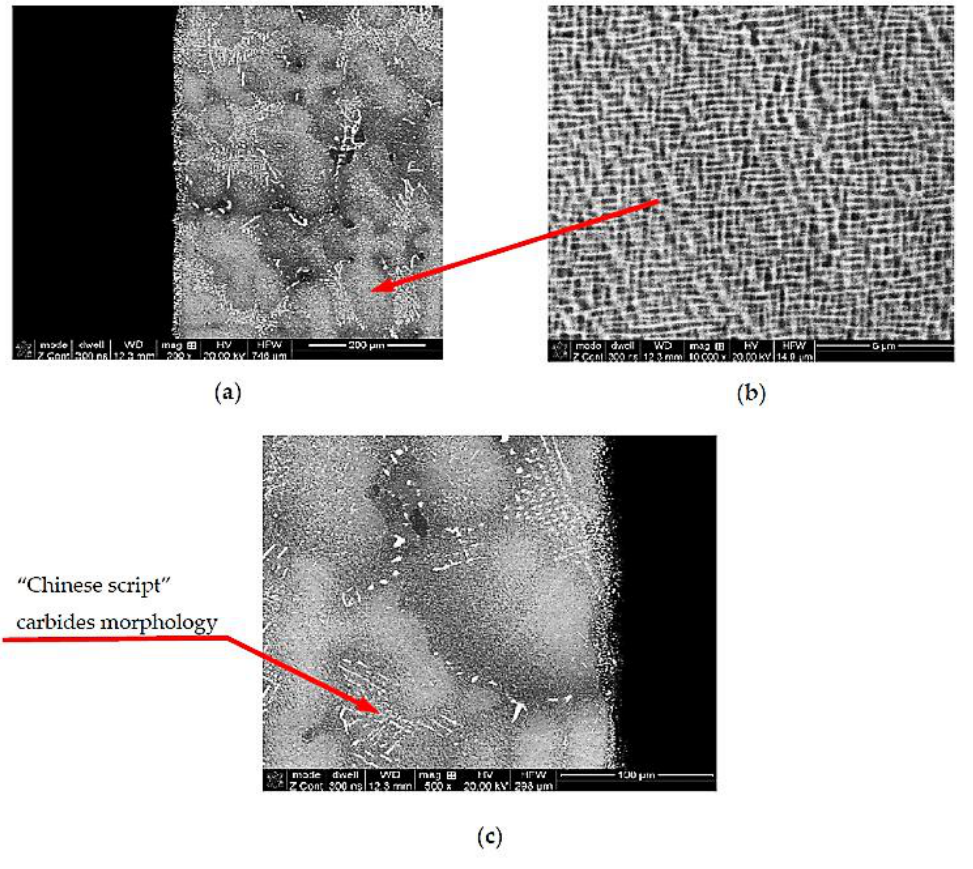
Figure 10. Multiphase structure of the TWC blade material built on the matrix of the γ phase ( a ), with cuboidal precipitates of the intermetallic phase γ’ ( b ) and reinforcing carbide precipitates ( c ).